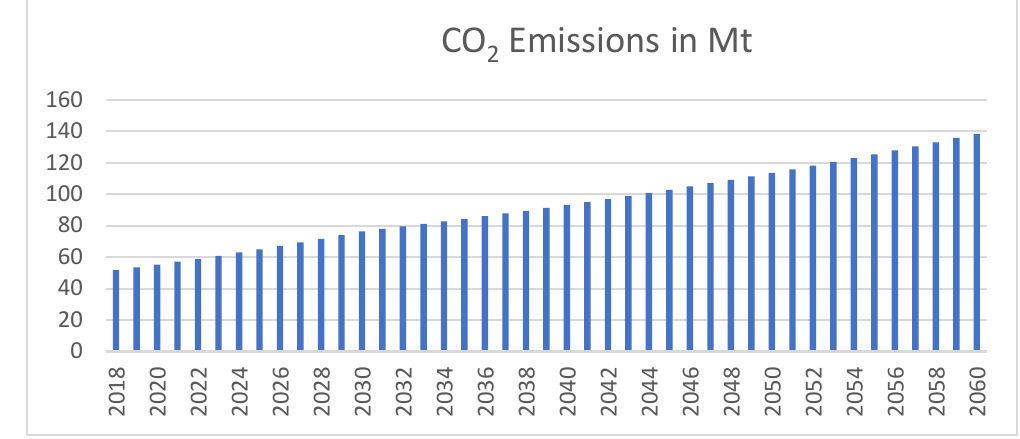
Figure 10. CO 2 emissions forecast: cement industry and cement production.